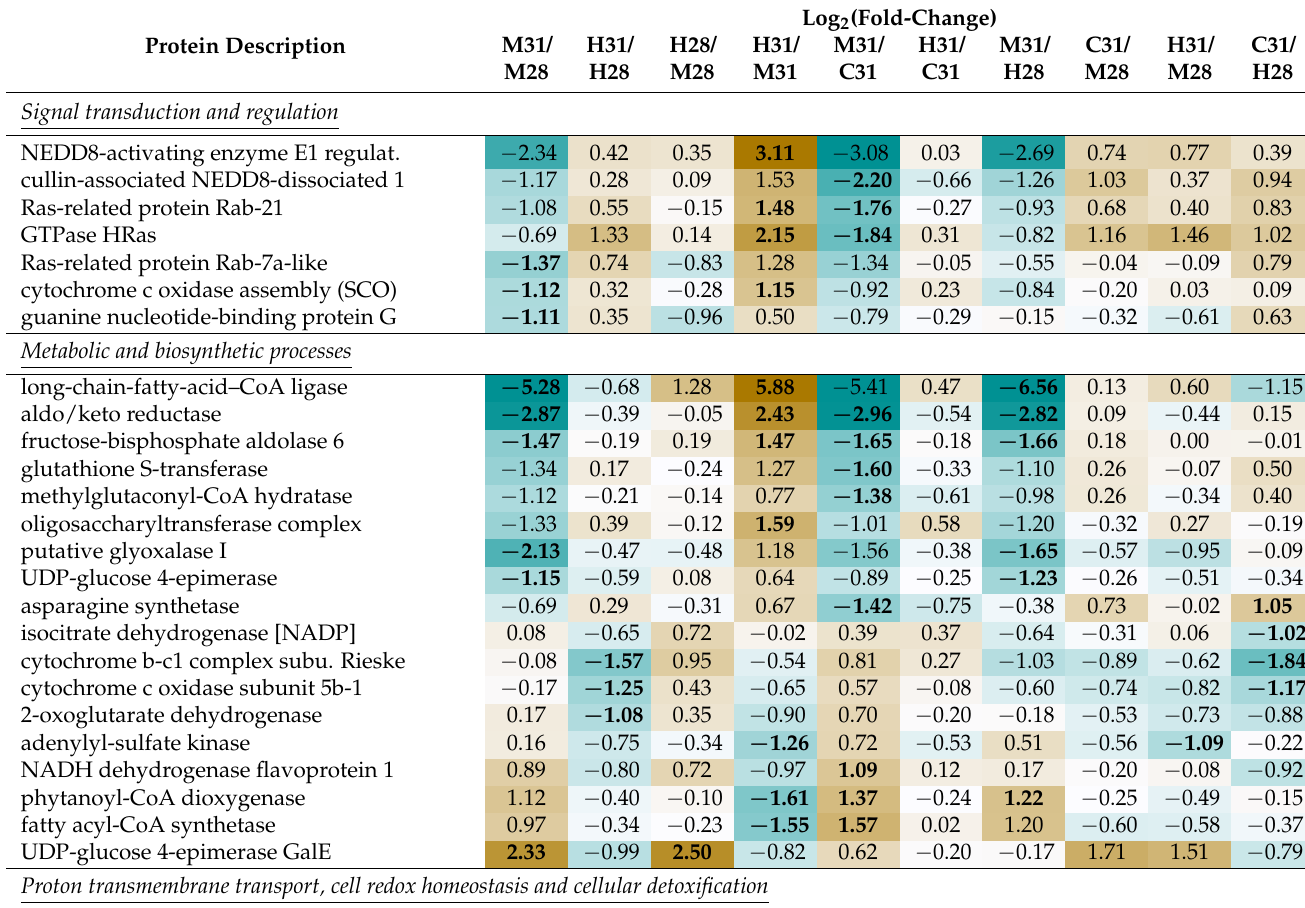
Table 4. Regulated proteins of host foraminifera Amphistegina lobifera in response to elevated p CO 2 (‘C’ = 492 ppm, ‘M’ = 963 ppm, and ‘H’ = 3182 ppm) at 28 ◦ C or 31 ◦ C, without the C28 treatment (GLM, q ≤ 0.05, Tukeys’ p ≤ 0.05, and log 2 FC ≥ |1|). Proteins are arranged by their major functions and processes according to GO terms; however, these roles are not exclusive as many proteins can have various functions. Directions and intensities of log 2 FC are illustrated by color, significant differences in average protein abundance between treatments are denoted in bold. Respective annotated gene ontologies, accession numbers, and remaining DAPs are provided in Table S6.